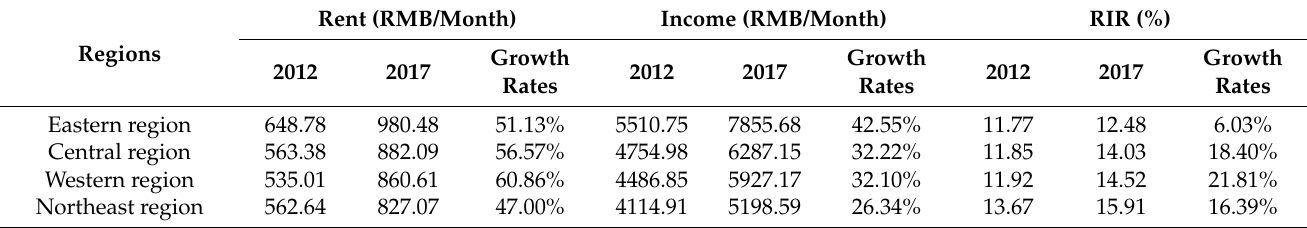
Table 3. Rent, income, and RIR of cities in different regions, 2012 and 2017.